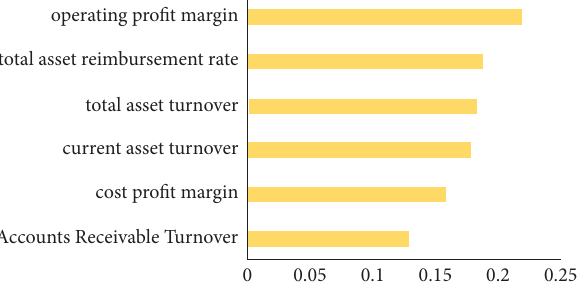
Figure 7: Importance of variables in enterprise operational risk